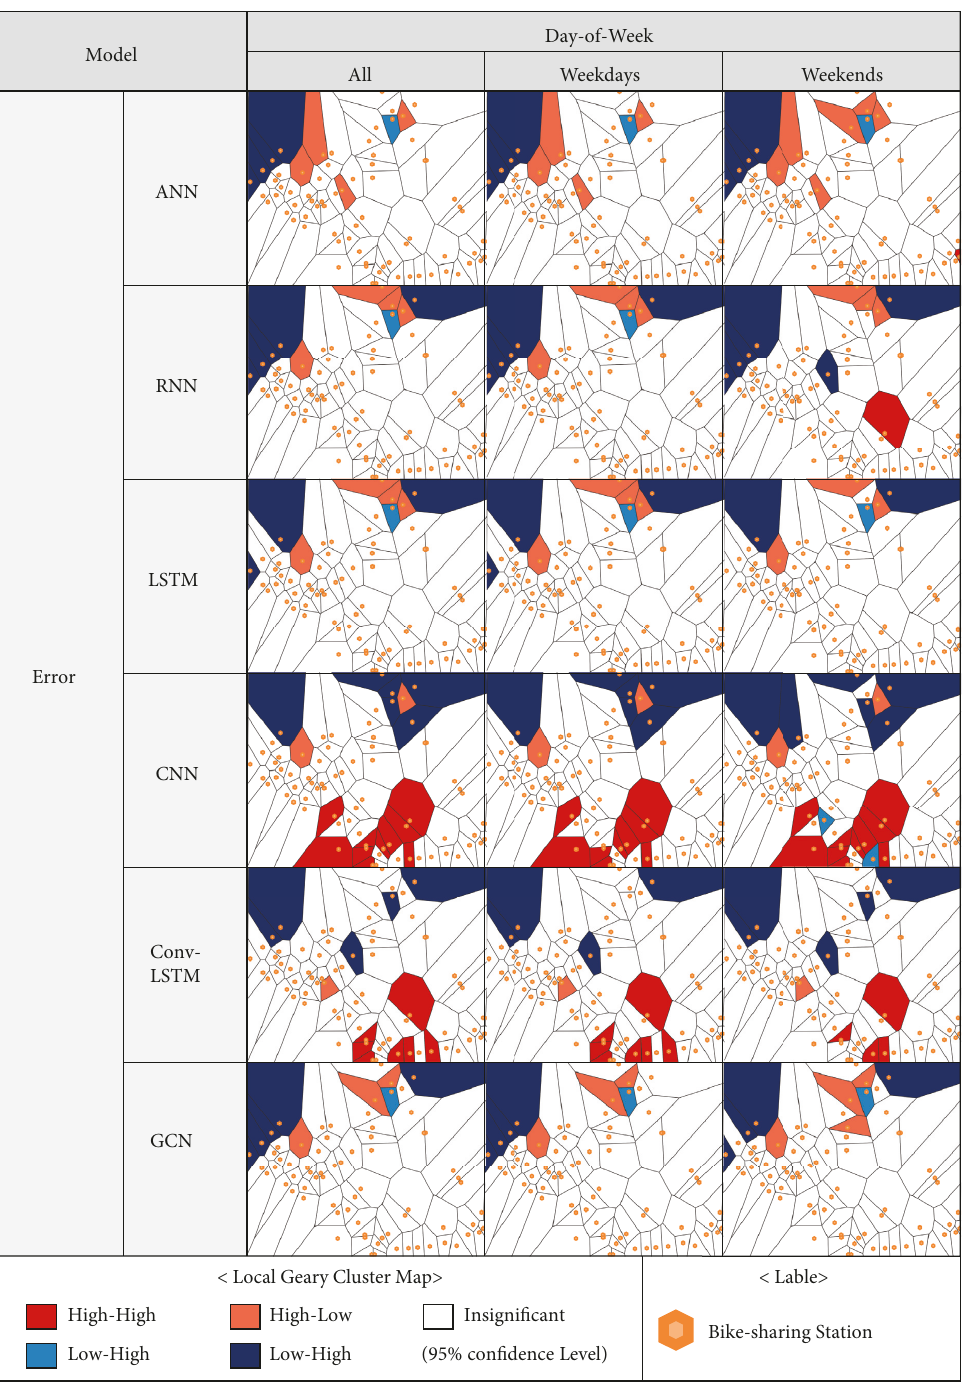
Figure 6: Results of cluster and outlier analyses for